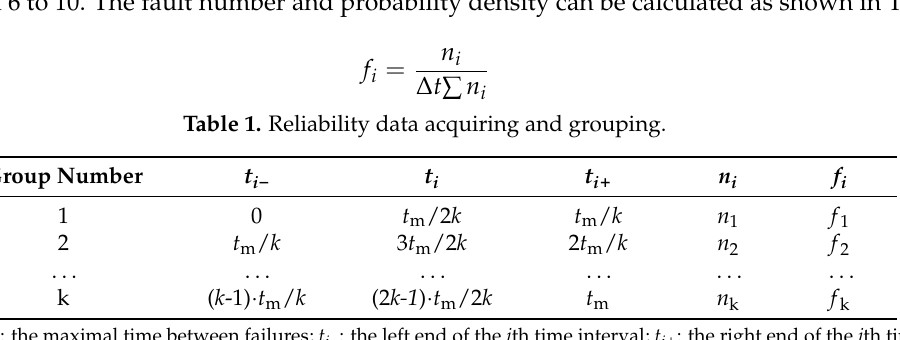
Table 1. Reliability data acquiring and grouping.